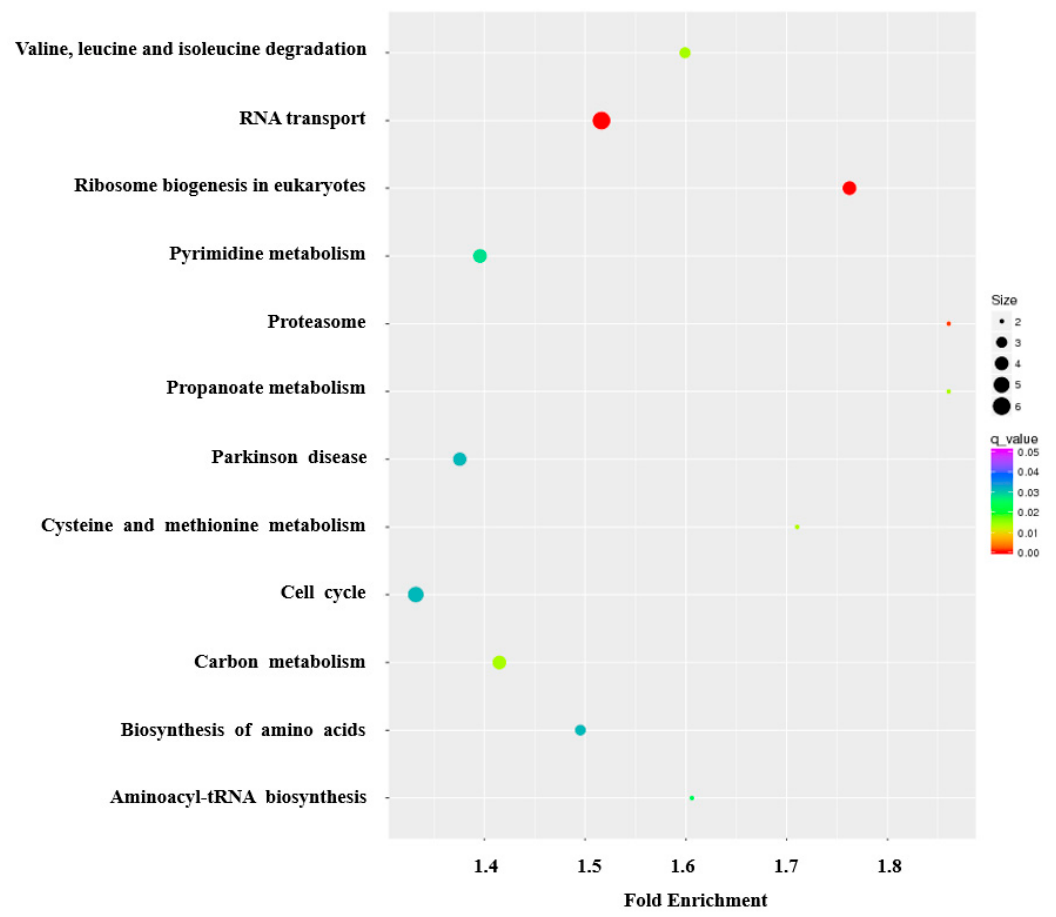
Figure 5. The KEGG pathway analysis of the differentially expressed genes, shown in bubble chart format. The Y-axis label represents significant pathways, and the X-axis label represents fold enrichment. The size of the bubbles represents the levels of differentially expressed genes enriched in the pathway. The color of the bubbles represents significance.